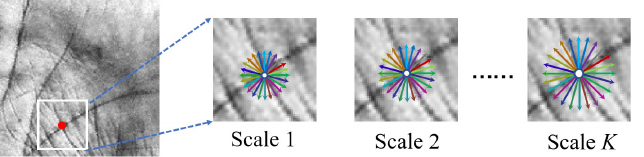
Figure 7. The brief pipleline of local orientation feature extraction from the ROI image.